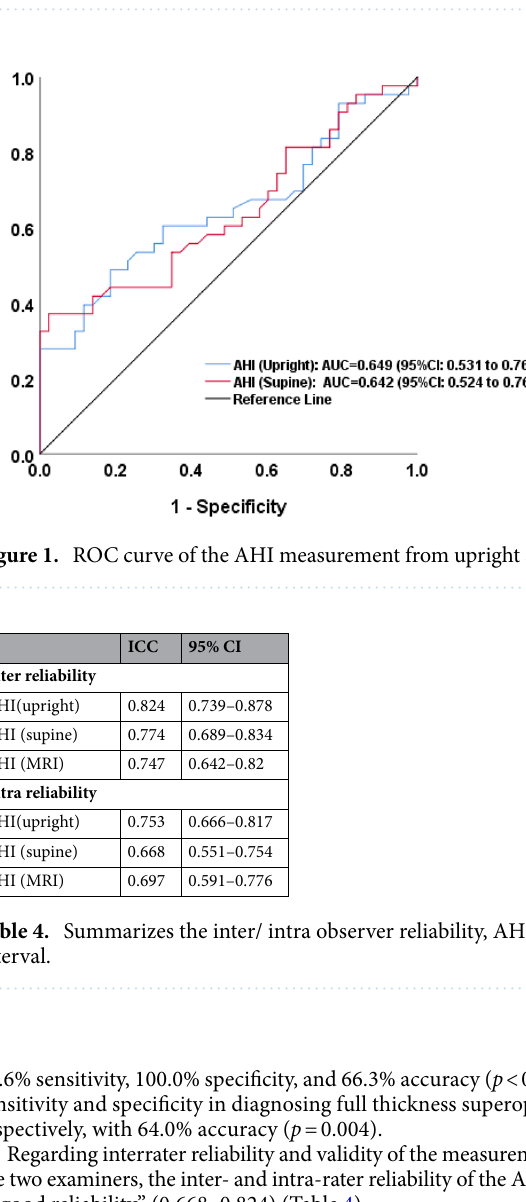
Table 3. Summarizes the AHI measurement according to tear size group. (NFT = non-full thickness tear, FT = full thickness tear). p value by ANOVA test and Paired t test.